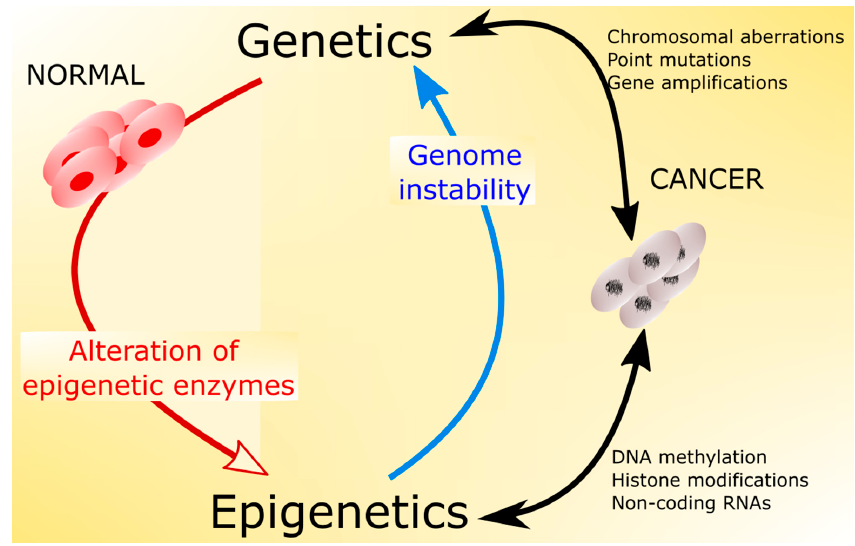
Figure 3. The interplay between genetic and epigenetic factors in cancer transformation. Genomic instability, typical for most cancers, results in an increased number of mutations in genes encoding modifiers of the epigenetic profile. On the other hand, epigenetic changes, including DNA methylation, histone modification, and changes in non-coding RNAs, a ff ect the expression of genes responsible for the maintenance of DNA, resulting in an increased number of chromosomal aberrations, DNA point mutations, amplifications, and other changes increasing genome instability.